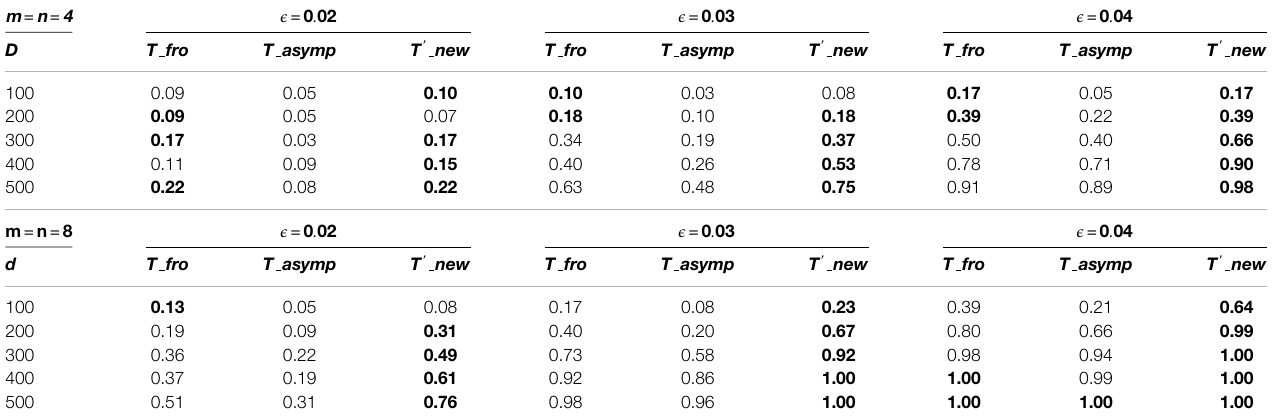
Bold values indicate the largest power of the test under each